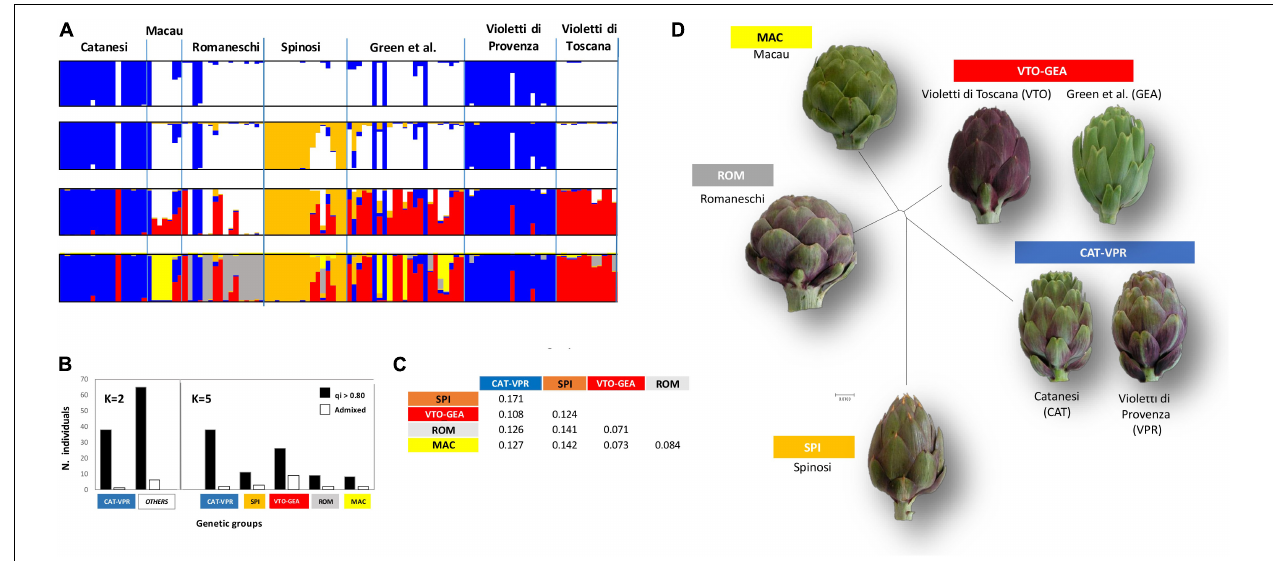
FIGURE 1 | Structure analysis. (A) Individual to population assignment. Individuals are ordered and grouped according to a priori knowledge of phenotypic typology. (B) Distribution between groups of individuals assigned (q i > 0.80) or admixed ( q < 0.20) at K = 2 and K = 5. (C) Net-nucleotide distances between pairs of genetic groups ( K = 5). (D) Neighbor-joining (N-J) tree depicting distances between groups ( K = 5); the N-J tree was drawn by Structure software based on the pairwise net-nucleotide distances among the five detected groups.